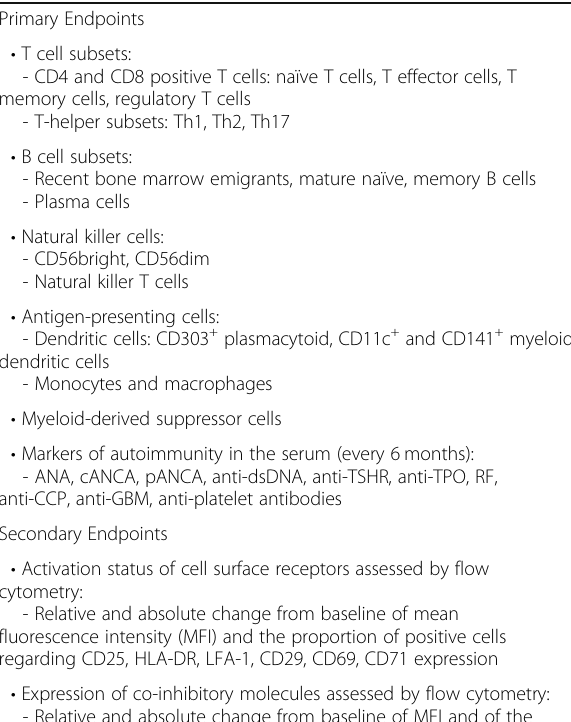
Table 2 Endpoints of the